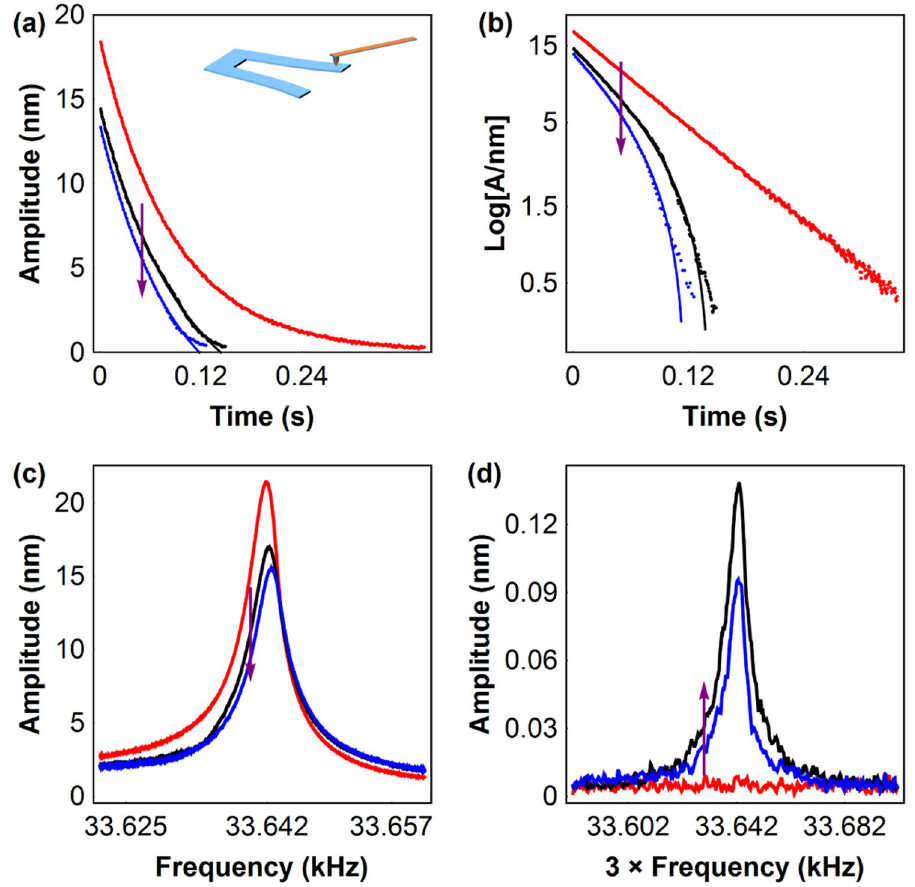
Figure 3. Driving a quartz tuning fork while applying a normal load (0–10 nN): ( a ) and ( b ) ring down experiments, where the excitation is turned off and the oscillator speed decays. Experimental data is presented as solid lines and fits of equation (17) are presented as dots. ( c ) Frequency response of the oscillator with different applied loads. ( d ) Frequency response of the oscillator measured around ω 0 , when driving it near ω 0 /3. All experiments were performed using similar loads. The red curve corresponds to the free oscillator and the arrow represents increasing